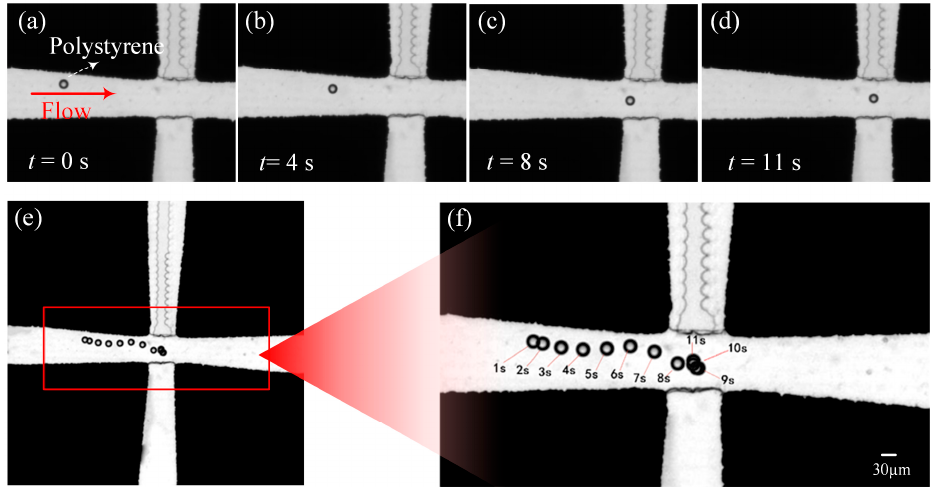
Figure 8. A 30 µ m polystyrene particle trapping experiment; ( a ) at 0 s, ( b ) at 4 s, ( c ) at 8 s, ( d ) at 11 s, ( e ) overlay result of the video sequence, and ( f ) the enlargement of ( e